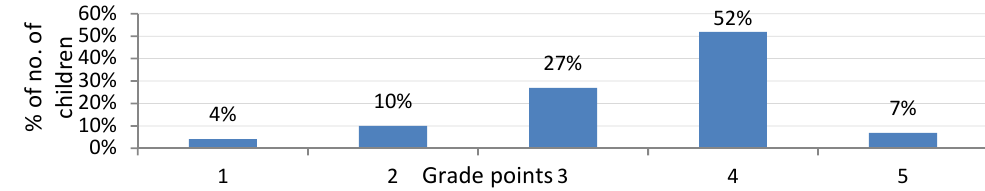
Grade Fig. 6: Children overall feedback ratings to the questionnaire